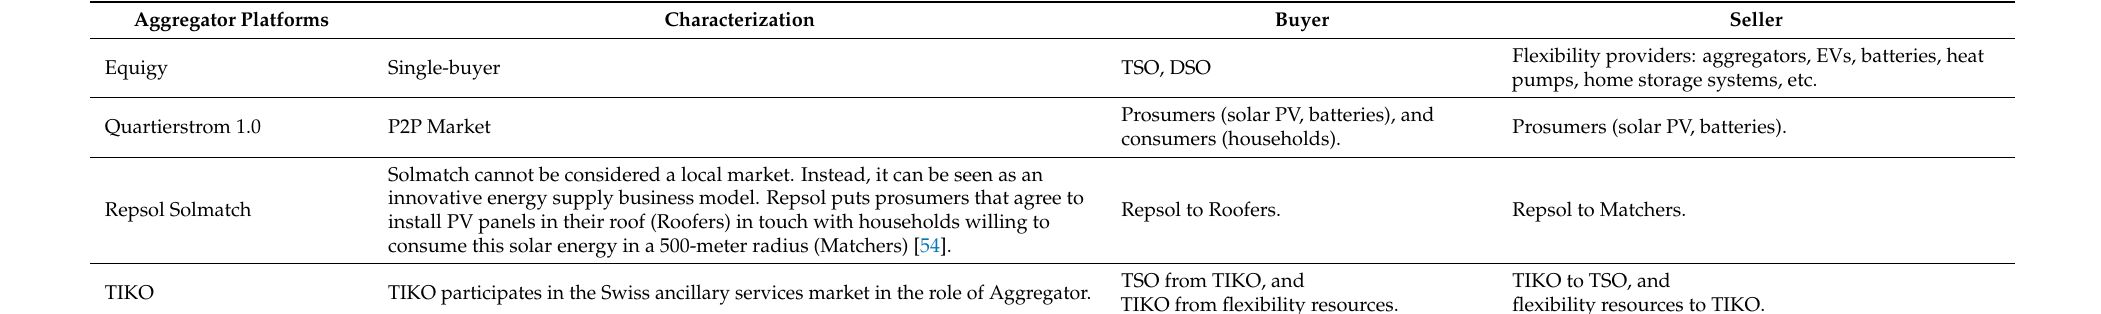
Table 6. Market structure of the aggregator platforms.